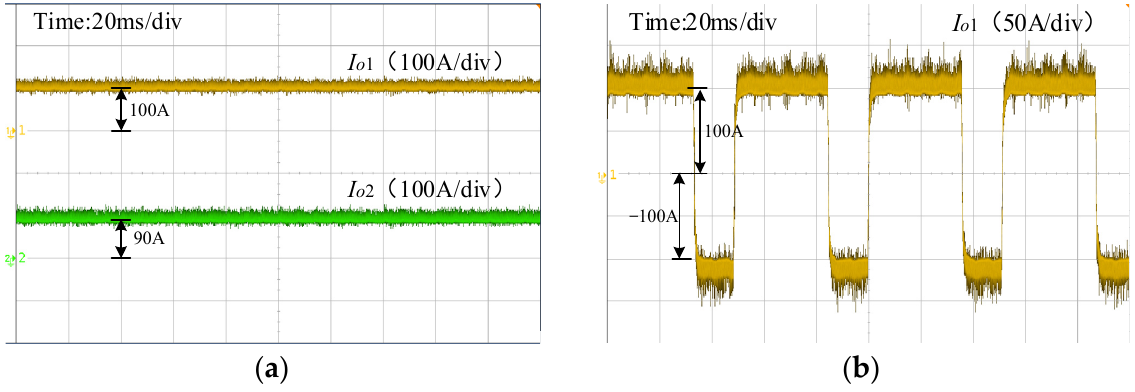
Figure 15. Steady state output waveform. ( a ) Dual DC currents ( b ) AC current. In the working state of the small-signal process, the duty cycle change will not be drastic. When the input voltage changes drastically, it can be quickly adjusted to the given current. As shown in Figure 16, compared with the traditional control system with PI regulation only, the current system changes steadily and adjusts quickly. During welding, the stable current can keep the welding arc stable.